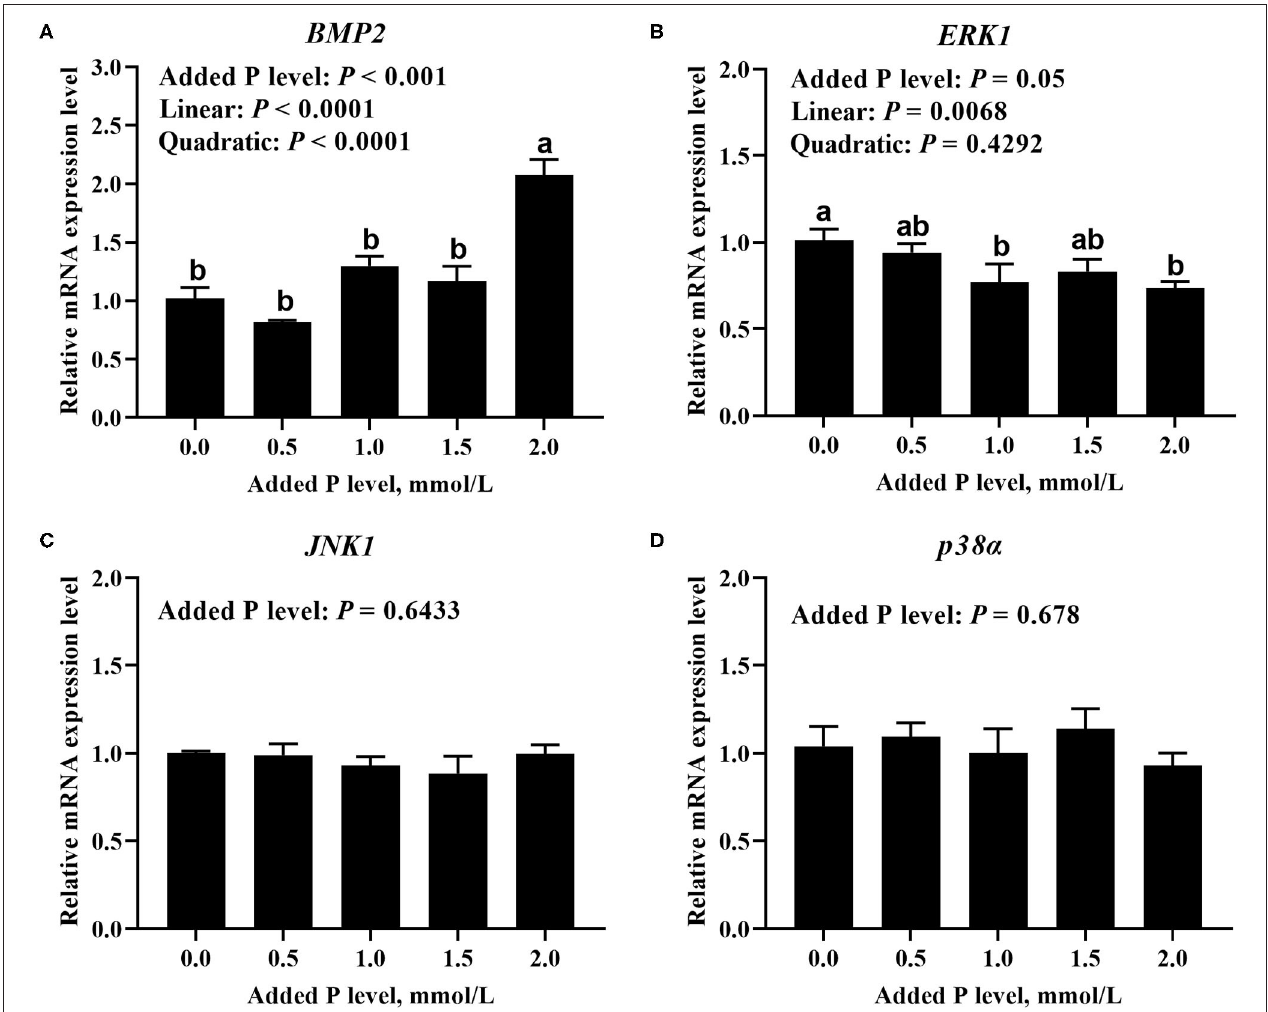
FIGURE 5 | Effect of added P level on the mRNA expression levels of BMP2 (A) , ERK1 (B) , JNK1 (C) , and p38 α (D) in primary cultured tibial osteoblasts of broiler chicks. Each value was mean ± SE, n = 6. Means without a common letter differ, p ≤ 0.05. BMP2 , bone morphogenetic protein 2; ERK1 , extracellular signal-regulated kinase 1; JNK1 , c-Jun N-terminal kinase 1; p38 α , p38 mitogen-activated protein kinase